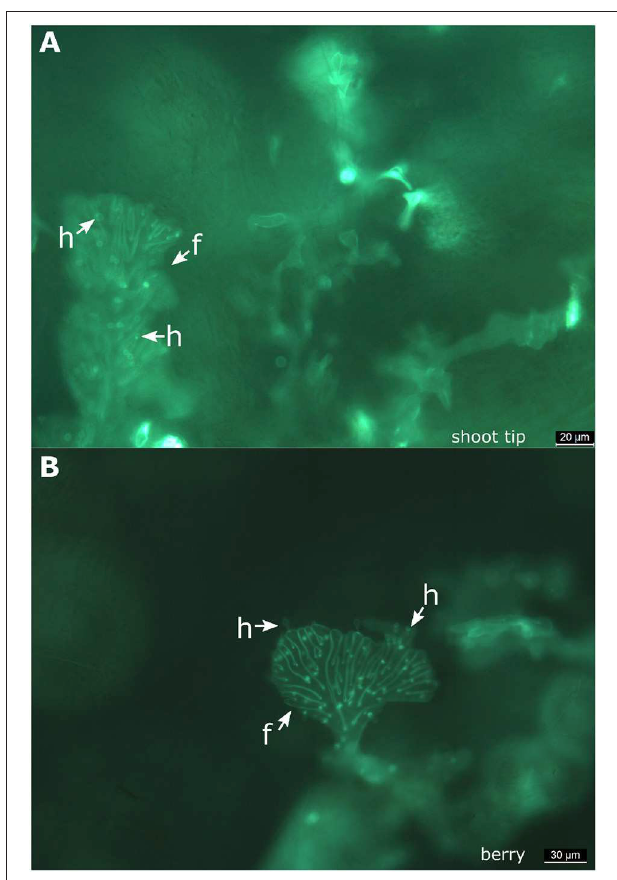
FIGURE 5 | Fan-shaped hyphae forming haustoria. Microscopic views taken from a shoot tip (A) and from a berry (B) of “Müller-Thurgau.” It is evident that the fan-shaped hyphae of P. viticola produce haustoria in these tissues. f, fan-shaped hyphae; h,